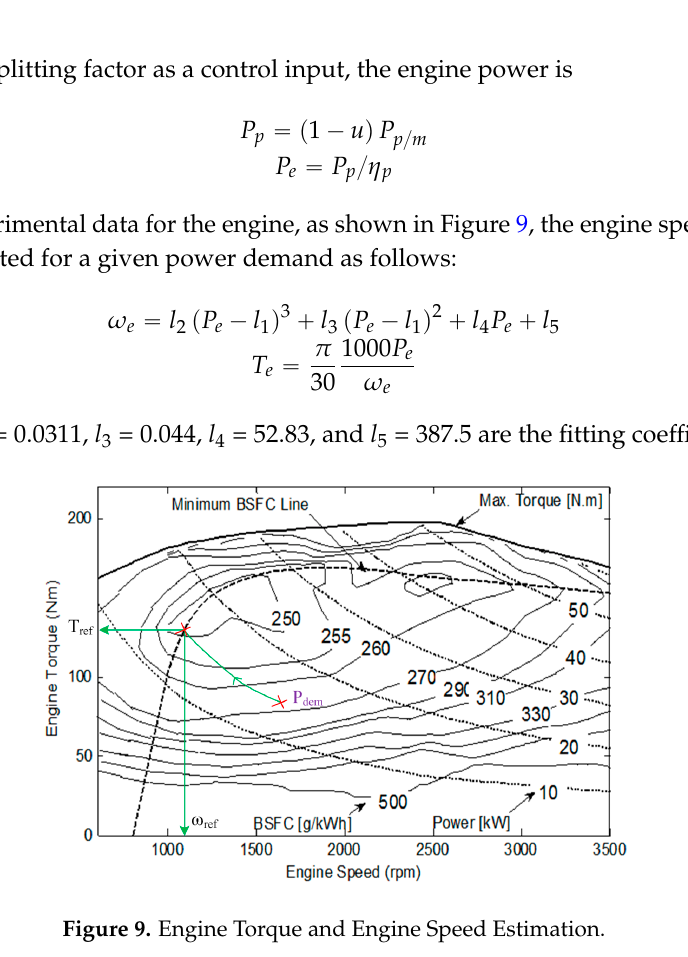
Figure 9. Engine Torque and Engine Speed